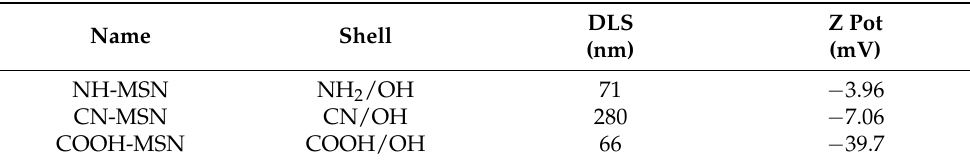
Table 1. DLS and Zeta potential of mesoporous silica nanoparticles in